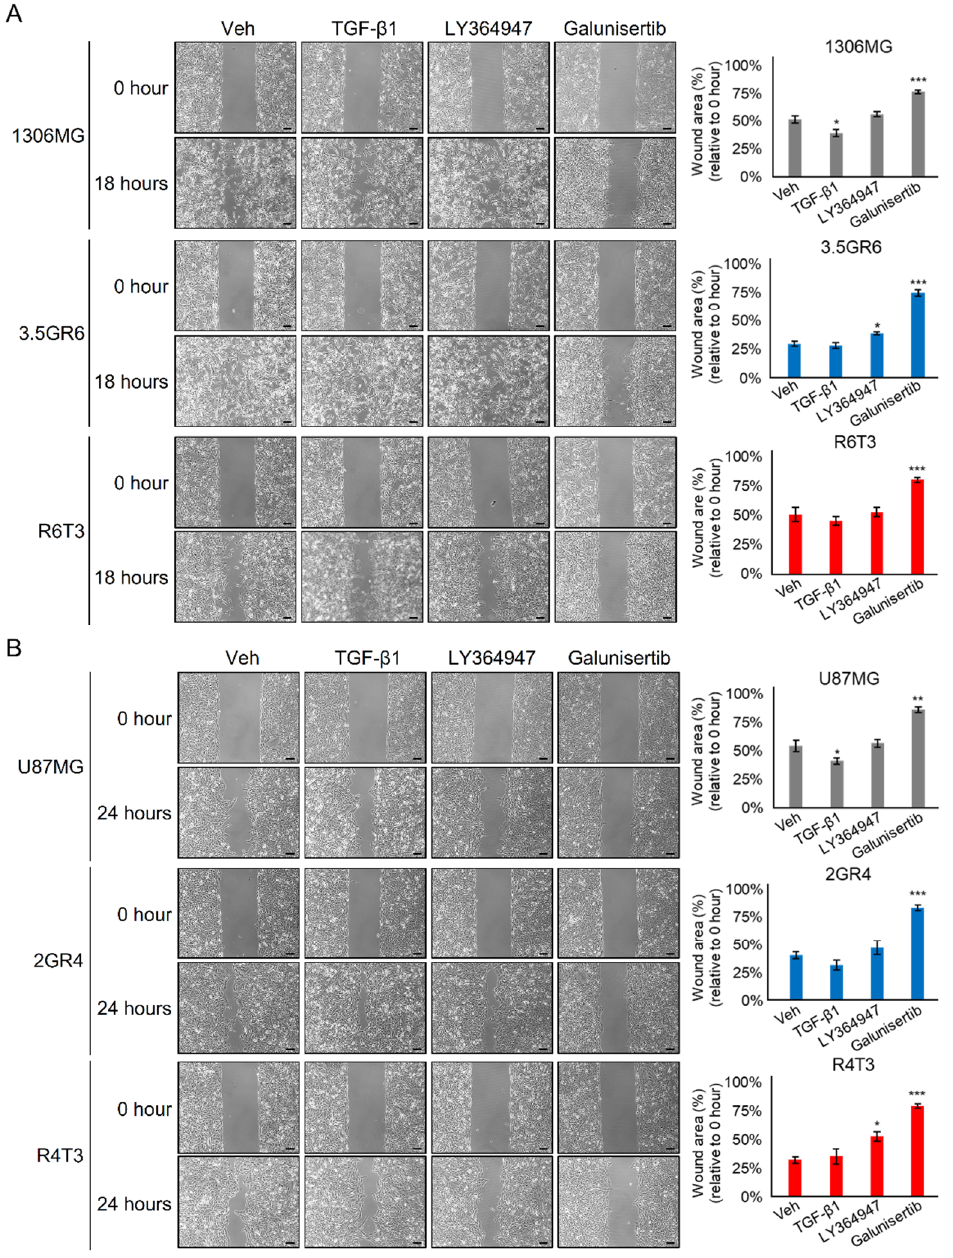
Figure 2. Suppressing TGF- β signaling reversed therapeutic resistance-facilitated cell motility. TGF- β signaling was blocked by both 4 µ M LY364947 and 100 µ M Galunisertib. Wound healing was used to evaluate cell migration. 0.1% DMSO was used as vehicle control (Veh). ( A ) Graphs and histograms showing the cell migration of 1306MG, radiation-resistant 3.5GR6, and radiation-temozolomide (TMZ)-resistant R6T3; N = 3 for 1306MG and 3.5GR6; N = 4 for R6T3; ( B ) graphs and the histograms showing the cell migration of U87MG, radiation-resistant 2GR4, and radiation-TMZ-resistant R4T3; N = 3 for U87MG; N = 4 for 2GR4 and R4T3; scale bar = 100 µ m; mean ± SEM; * refers to a comparison with the control; *, p < 0.05; **, p < 0.01; ***, p < 0.001.